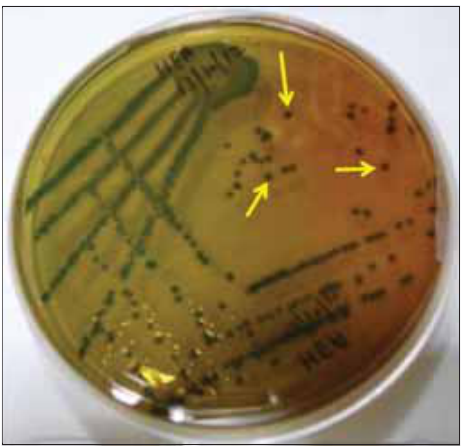
Figure-1: Growth of Salmonella Typhimurium E-2375 strain on Hektoen Enteric Agar plate. The cells were streaked and incubated at 37°C for overnight. Isolated colonies are depicted by arrows. Table-2: Results of nucleotide blast showing similarity of PIMT gene of S. enterica serovar Typhimurium strain E-2375 with other Salmonella serovars.